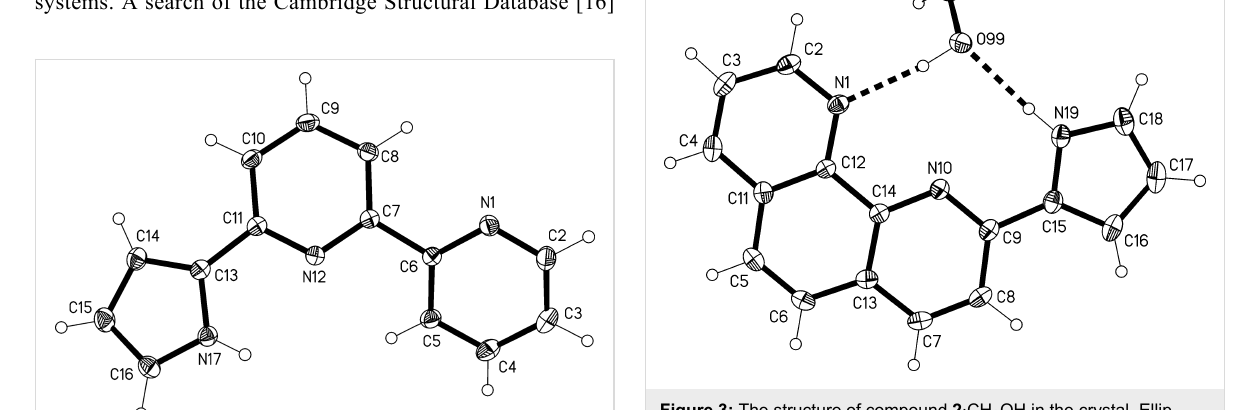
Figure 3: The structure of compound 2 ·CH 3 OH in the crystal. Ellip- soids correspond to 50% probability levels. Hydrogen bond details (Å,°) for N19–H19 … O99: H … O 1.96(2), N … O 2.839(1), N–H … O 174(1); for O99–H99 … N1: H … N 1.93(2), O … N 2.841(1), N–H … O